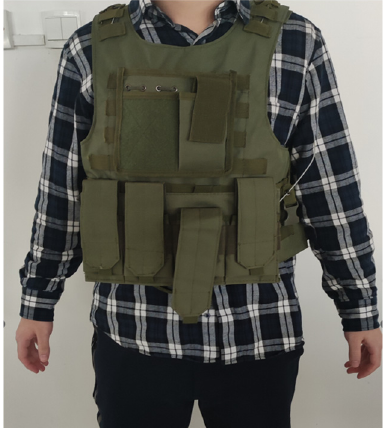
Figure 1. Wearable visual-inertial positioning undershirt equipment.